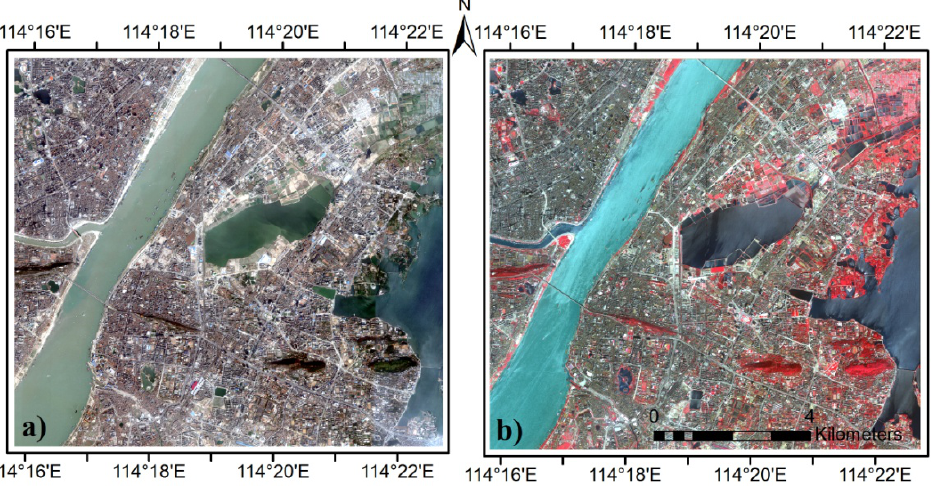
Figure 2. Satellite images used in this study ( a ): Google Earth (GE) image, ( b ): QuickBird (QB)